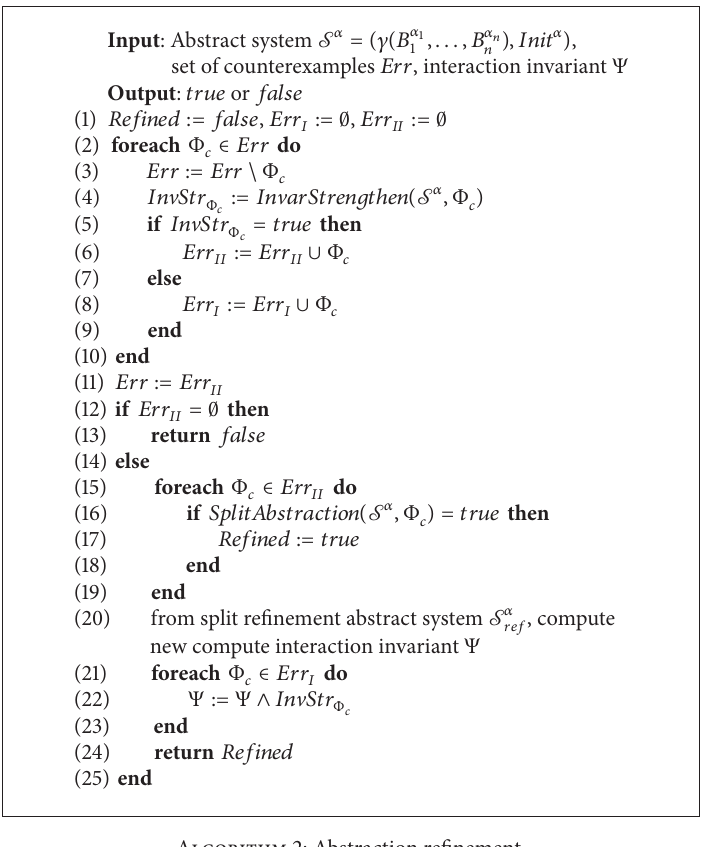
Algorithm 2: Abstraction refinement.